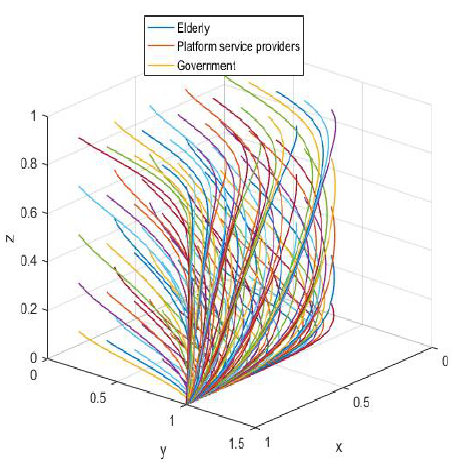
R F C , s , 2 , and 1